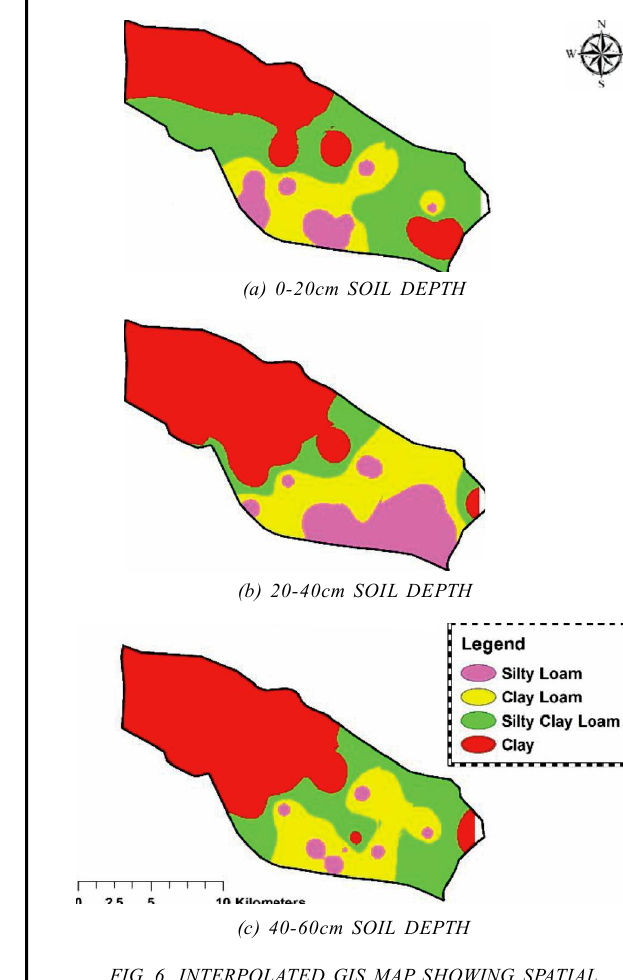
FIG. 6. INTERPOLATED GIS MAP SHOWING SPATIAL DISTRIBUTION OF SOIL TEXTURE